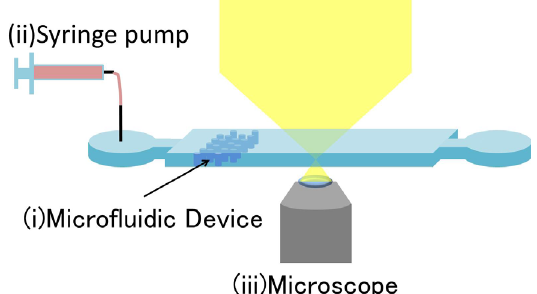
Figure 7. Schematic illustration of experimental setup. Cell suspension is introduced into (i) the microfluidic device by using (ii) a syringe pump. The cells are observed under (iii) a microscope.